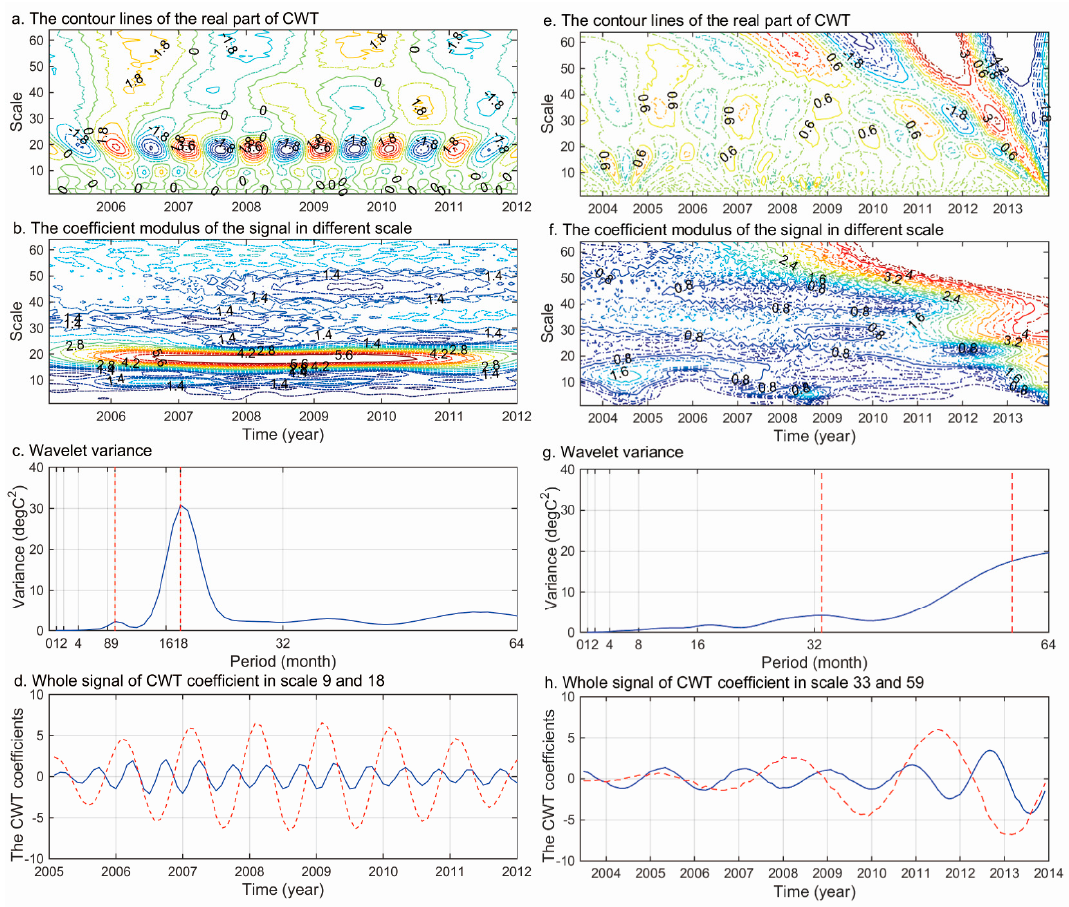
Figure 8. CWT on HHL and InSAR time series for Well 2: ( a ) the contour of the real part of the CWT analysis for HHL time series; ( b ) the coefficient modulus of the HHL time series in different scales. ( c ) wavelet variance curve of HHL time series; and ( d ) the CWT coefficients curve of HHL time series in different scales. ( e – h ) The same as ( a – d ) but for InSAR time series.